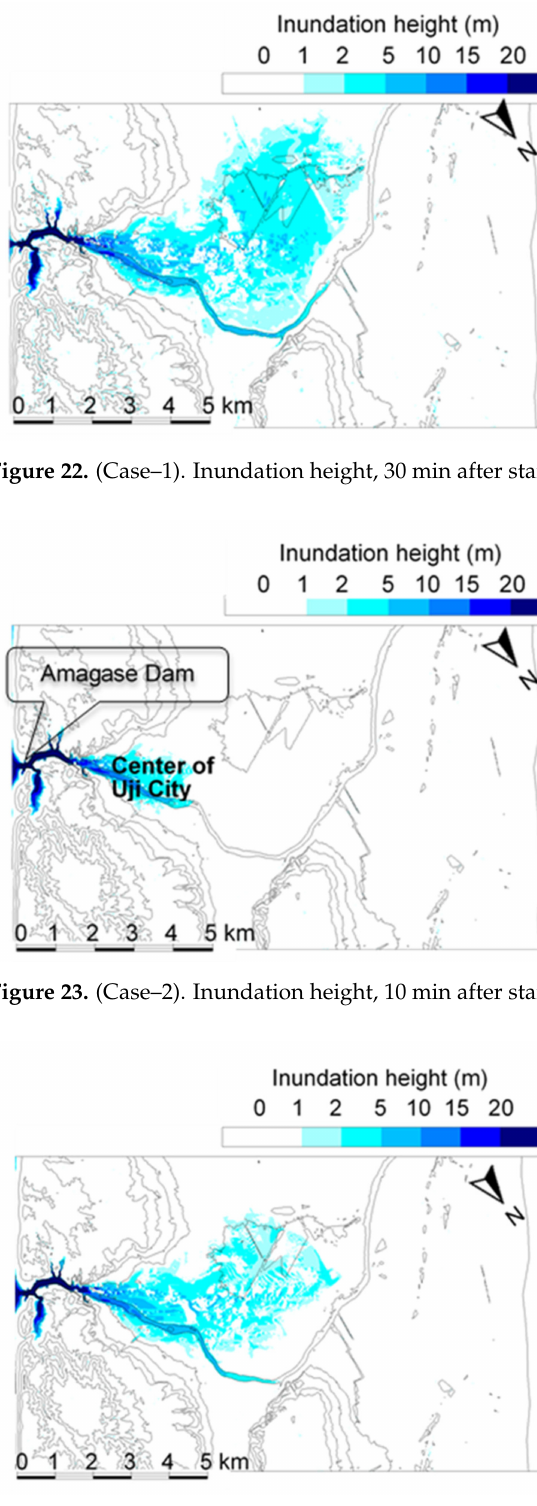
Figure 24. (Case–2). Inundation height, 20 min after start of the